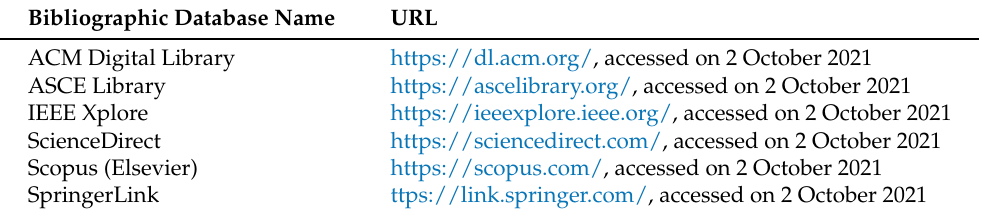
Table 3. SLR protocol: selected bibliographic